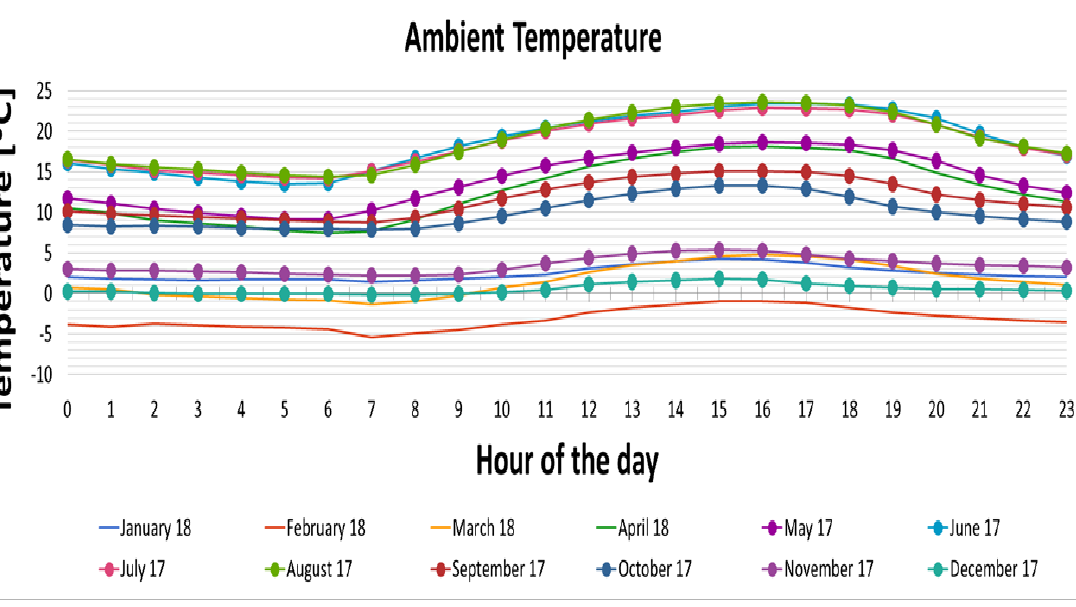
Figure 4. Ambient temperature on a monthly basis given in 24 hours per